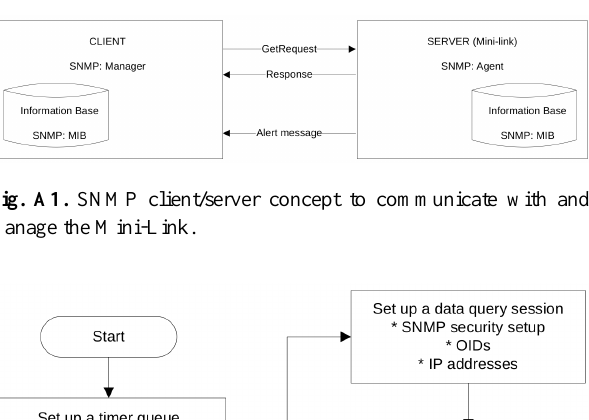
Fig. 15. Empirical probability density functions of attenuation val- ues for dry and rainy periods (for dataset 1). The dashed lines repre- sent the fitted densities of a Gaussian distribution with same mean and variance as the samples. The dry and rainy periods are derived from the disdrometer data.